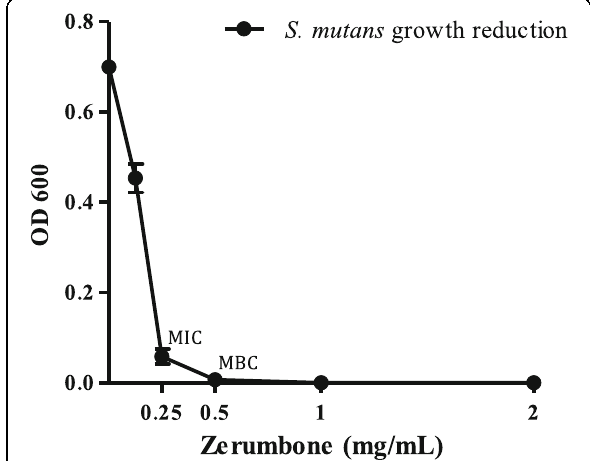
Fig. 4 Antimicrobial activity (MIC and MBC) of zerumbone against S. mutans. Bacterial inoculum (1×10 6 CFU/mL) was treated with different concentrations of zerumbone and incubated at 37 °C for 48 h in anaerobic conditions. After incubation, the bacterial growth was verified by turbidity measurements using spectrophotometer. The results are representative of three independent experiments performed in triplicate and the values are shown in mean ± SD. OD: optical density; MIC: Minimum Inhibitory Concentration; MBC: